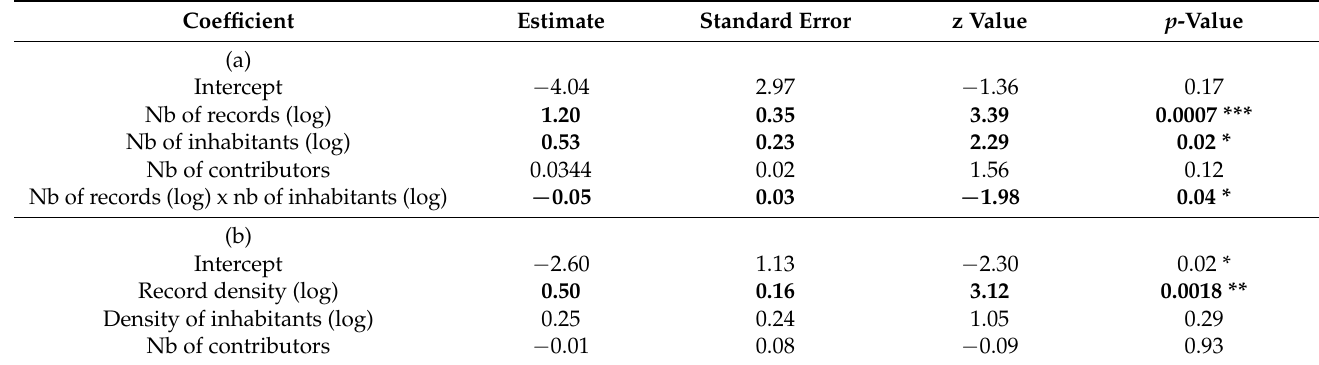
Table 2. Analysis of the correlation between the number (a) and density (b) of fungal species per km 2 at the department scale and the number and density of records per km 2 , and number and density of fungal species per km 2 , the number and density of inhabitants per km 2 and the number of contributors in FongiBase, using a generalized linear model procedure. The analysis excludes